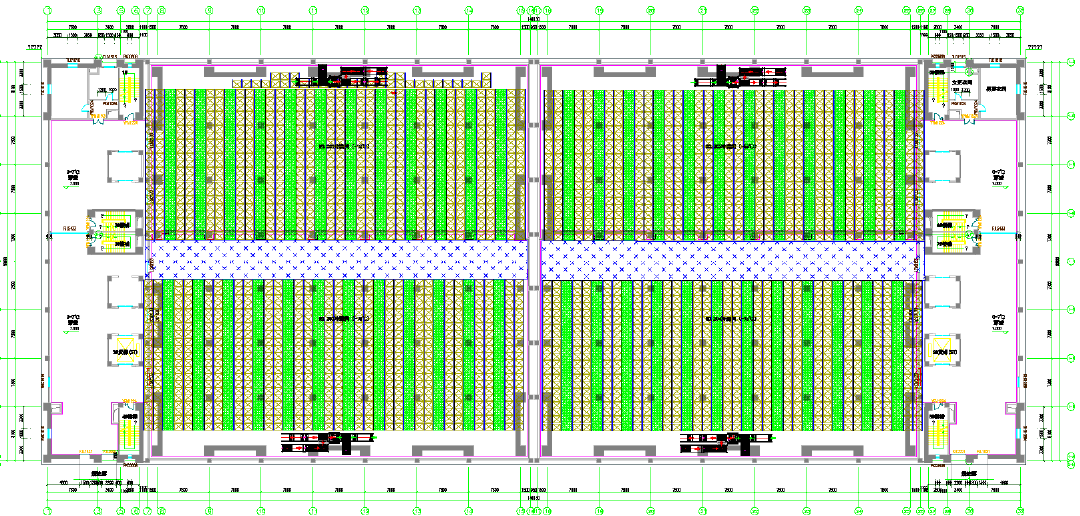
Figure 9. The layout for the double-deep multi-tier shuttle warehousing systems (DMSWS) of the logistics distribution center.